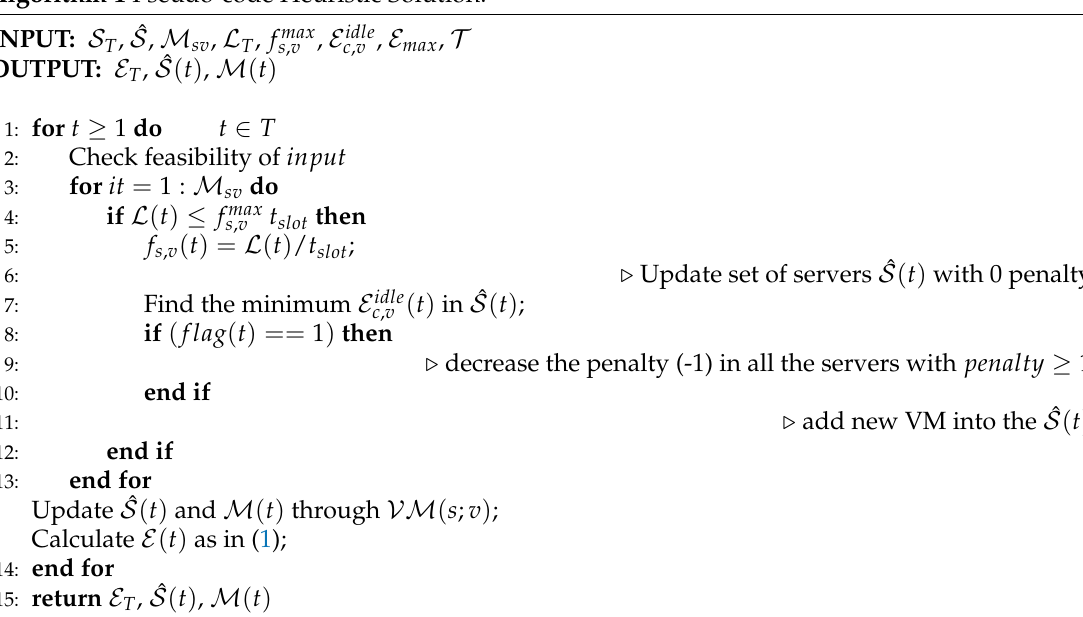
Algorithm 1 Pseudo-code Heuristic